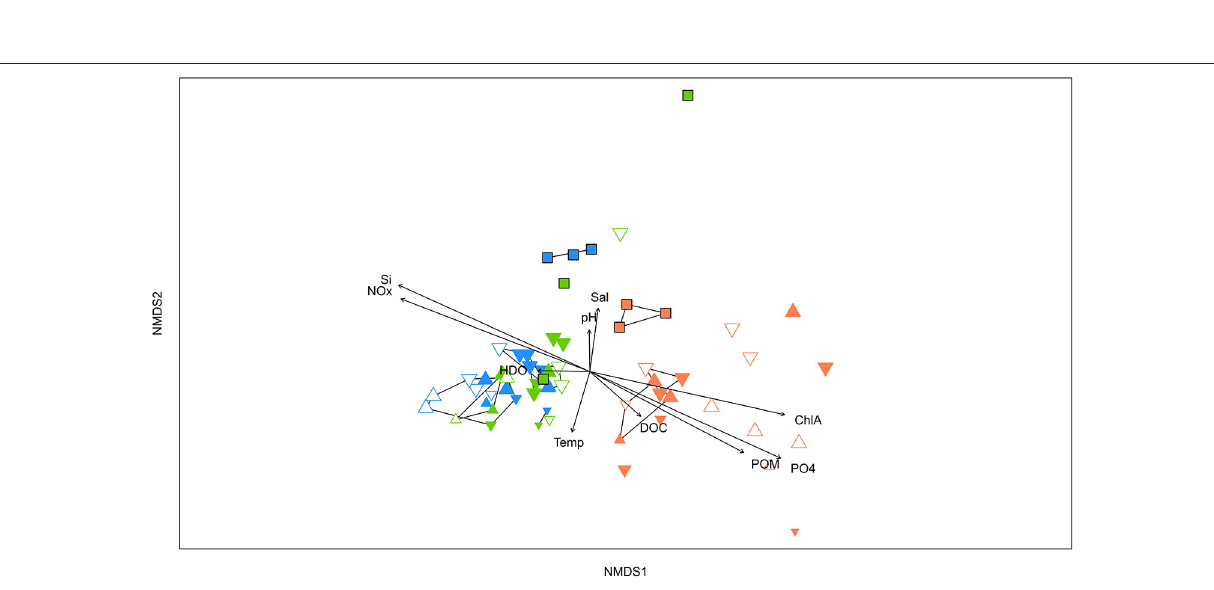
FIGURE 6 | Non-metric multidimensional scaling (NMDS) plot of bacterial communities on natural and artificial substrates overlaid with environmental parameters (Si, silicate; NOx, Nitrate + nitrite; Sal, Salinity; HDO, dissolved oxygen; Temp, Temperature; DOC, dissolved organic carbon; POM, particulate organic matter; ChlA, chlorophyll a; PO4, phosphate). Sampling sites are shown by colors; with inshore (LL) = orange; near-shore (BL) = green; and mid-shelf (BD) = blue. Natural surfaces are represented by squares, artificial ceramic tiles by triangles, with size, filling, and orientation depending on deployment time, position on tile stack and orientation